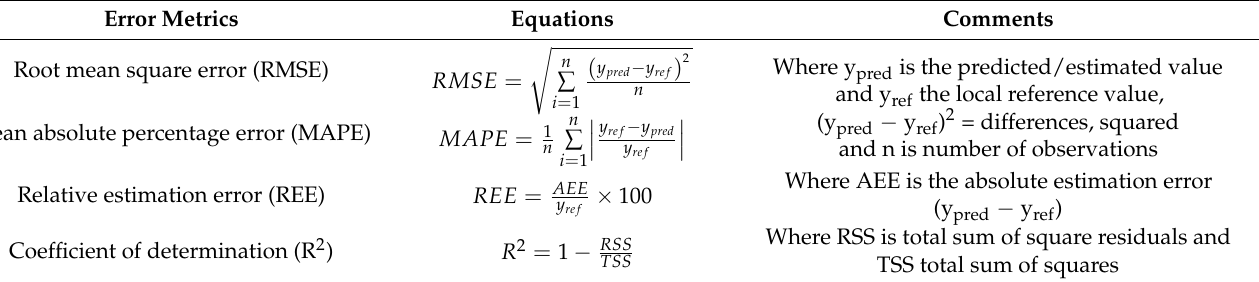
Table 3. Error Metrics used to assess the spatial distribution of the modelled population data. Error Metrics Equations Comments